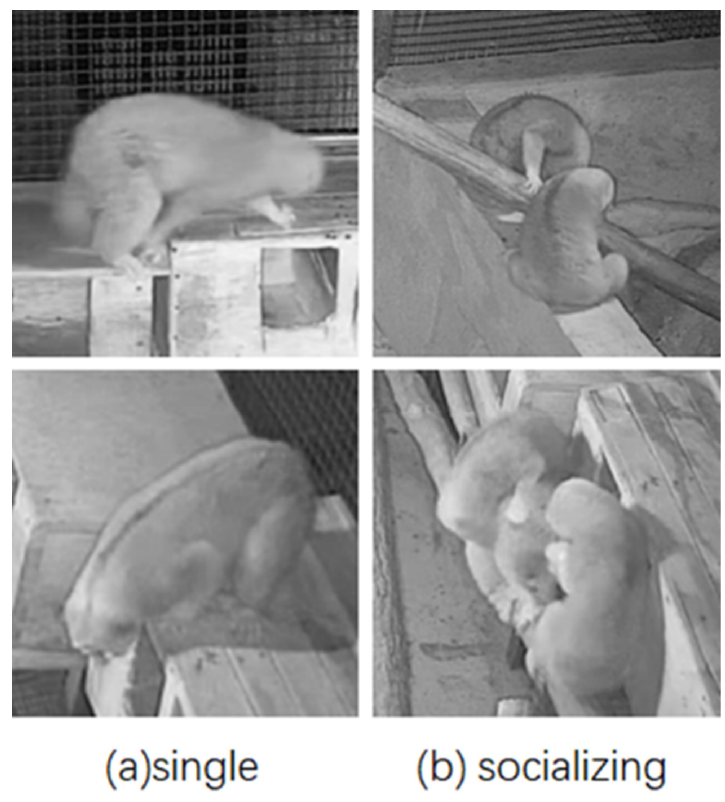
Figure 2. Example diagram of slow loris states.